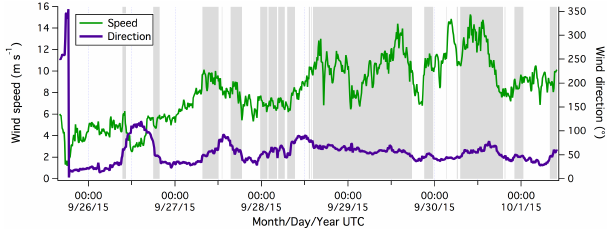
Figure A1. Time series of wind speed and direction during the Pi- carro (dry) vs. LGR (wet) period. The shaded region indicates the wind sector between 45 and 80 ◦ , which we consider to be represen- tative of air–water transfer.